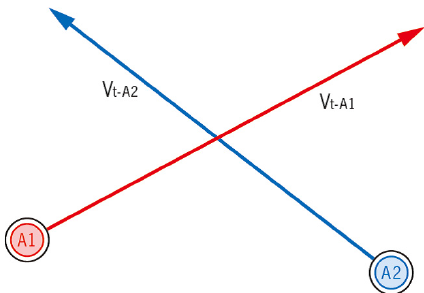
Fig. 12. AAs' original guidance to drive robots to the target